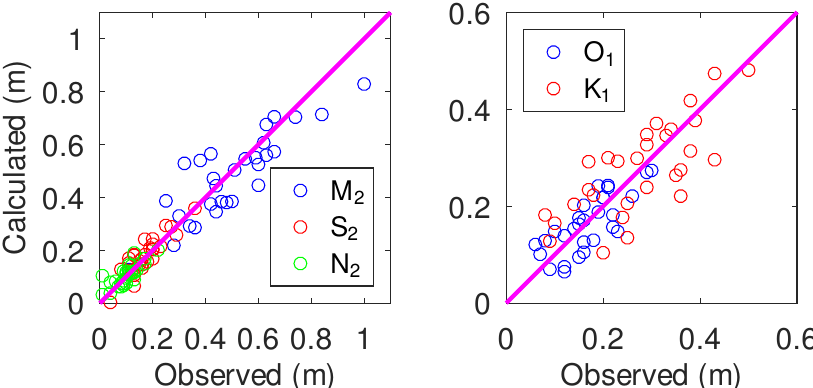
Figure 2. Comparison between calculated and observed amplitudes for the semidiurnal ( left ) and diurnal ( right ) constituents considered in the